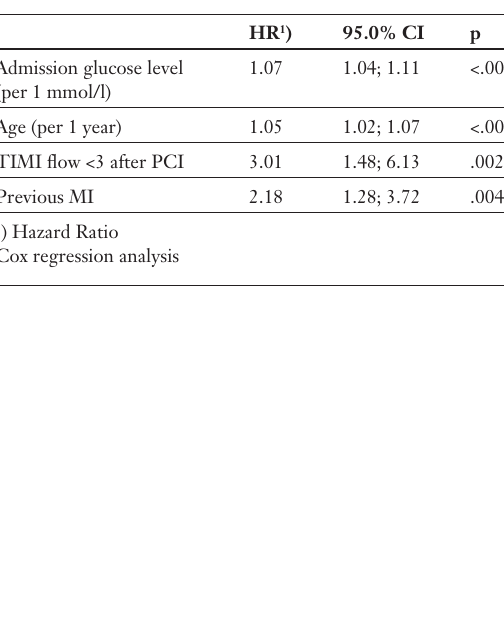
Independent predictors of in-hospital death. Independent predictors of post-discharge death.